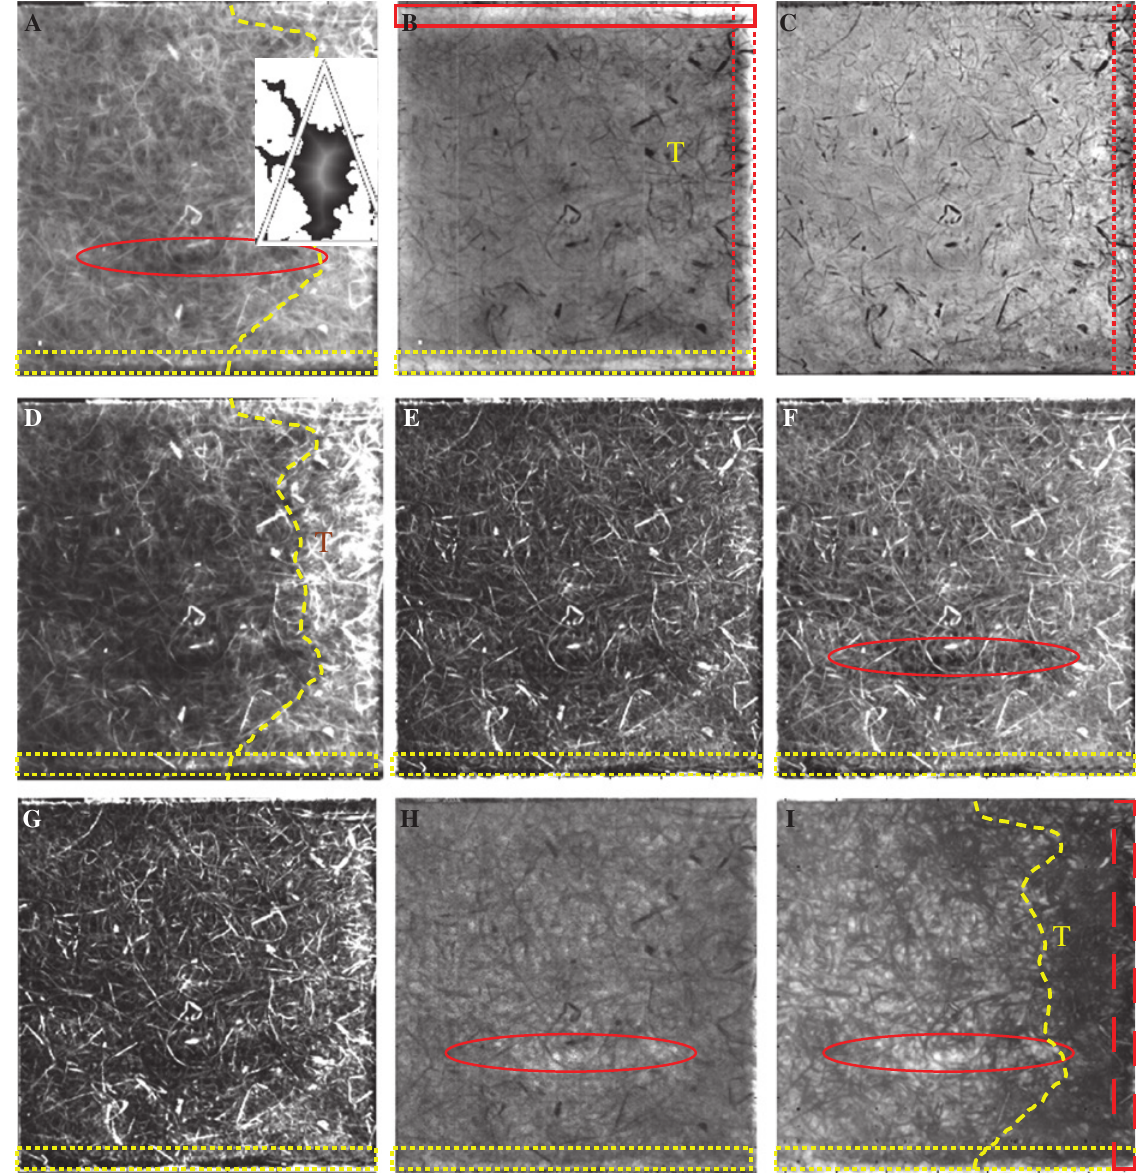
and DT result of Figure 12E, (B) PCT-EOF 2